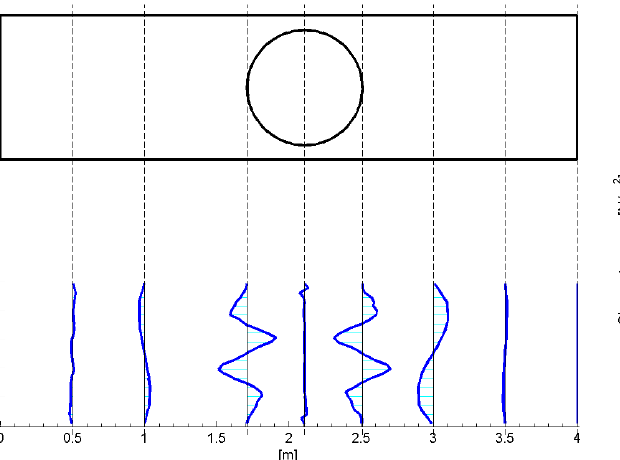
Figure 20: 3D plot of the shear stresses τ xy